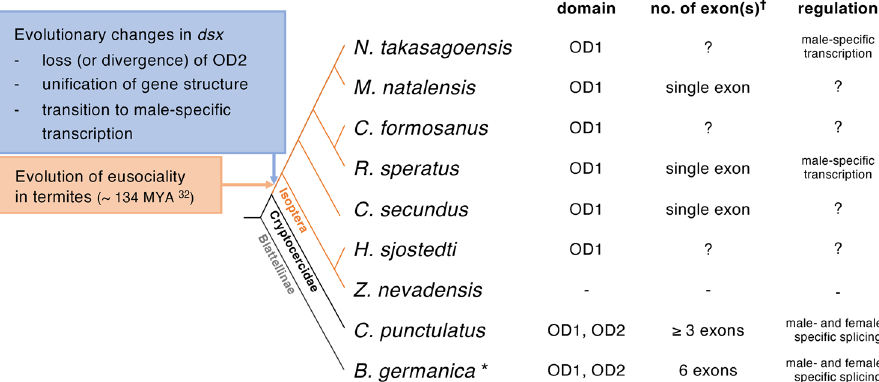
Figure 5. Evolutionary changes in dsx regulation associated with social evolution in termites. The presence of OD1 and OD2, numbers of exons containing coding sequences ( † ), and regulatory manner of dsx homologues were compared among the German cockroach, the subsocial woodroach, and seven termite species. “-” and “?” mean “not detected” and “unknown”, respectively. *Data on B. germanica were cited from Wexler et al. 9 . The tree topology was based on that of Bourguignon et al. 57 , Bucek et al. 31 , and Evangelista et al. 32